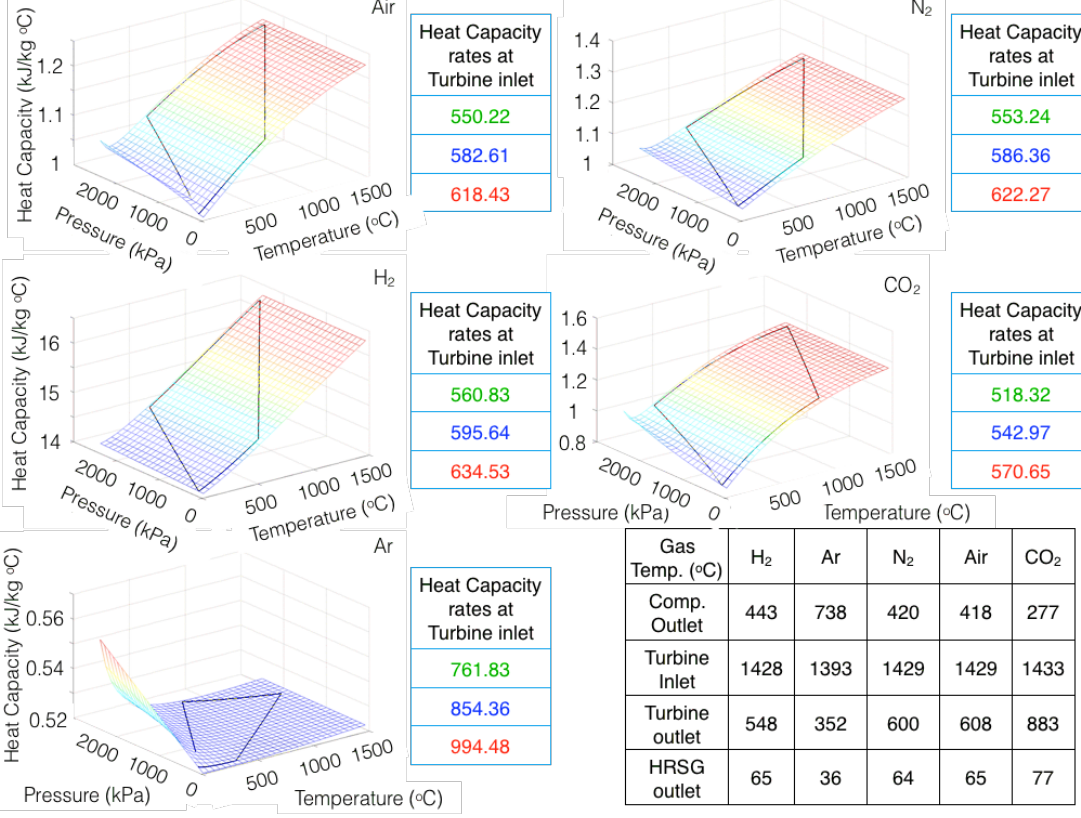
Figure 8. Heat capacity data for different fluids shown as 3D surface plots. Black lines represent the heat capacity profiles of the partitioned Brayton cycle at 92.7% adiabatic efficiency. Adjacent tables provide the heat capacity rates. Green, blue, and red represent these rates at adiabatic efficiencies of 95.63%, 92.7%, and 89.9%, respectively. The main table provides the mean temperatures at different locations of the partitioned cycle (η = 92.7%).